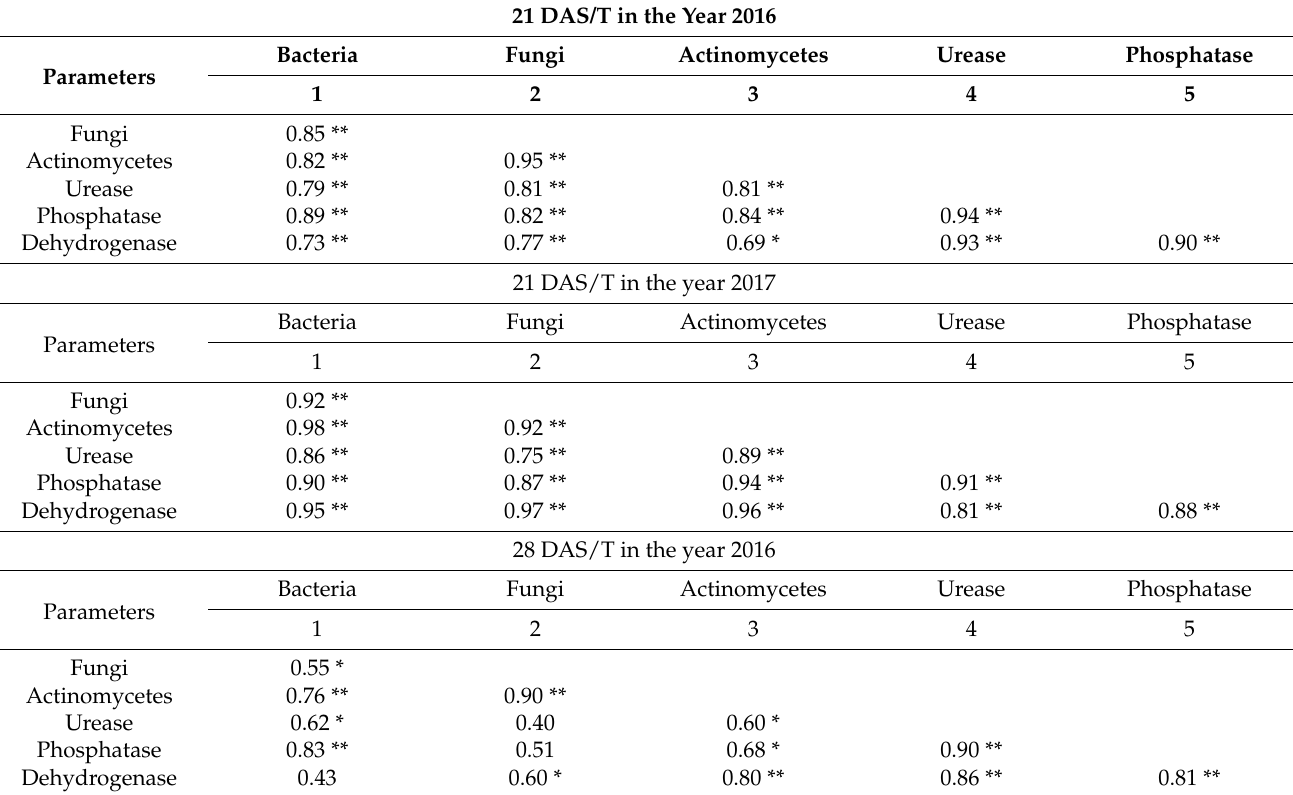
Table 12. Multiple correlations between micro-organisms and soil enzymes at different stages were recorded at 21 and 28 DAS/T in both